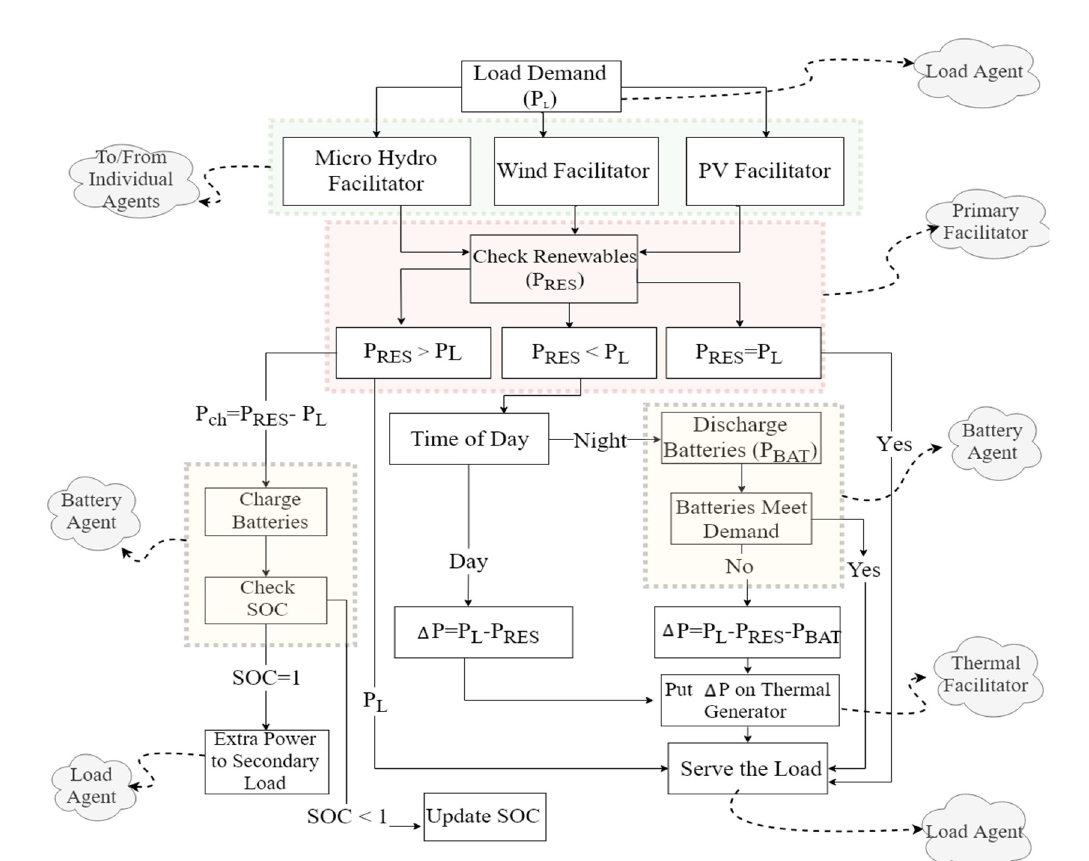
Fig 2: Proposed algorithm for decentralized control (The balloons represent the software block where the corresponding decision is taken) Agents of different elements in Microgrid coordinate together to form multi agent based decentralized